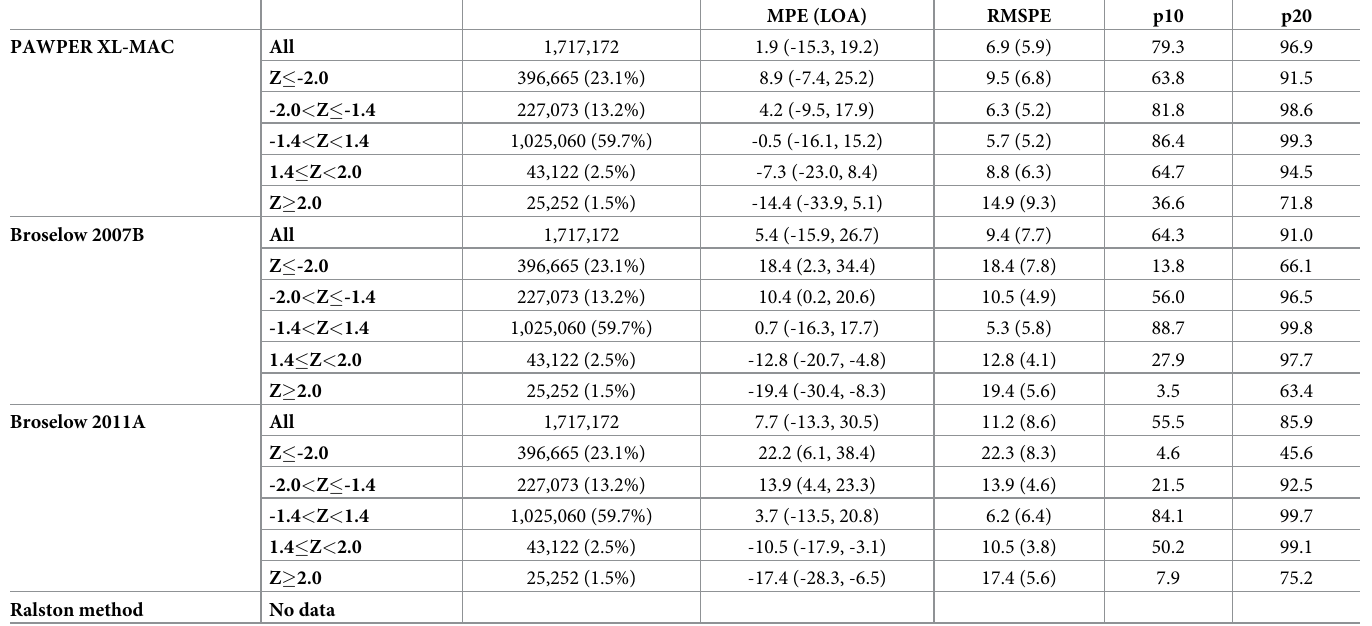
Table 6. Weight estimation performance by subgroups of weight